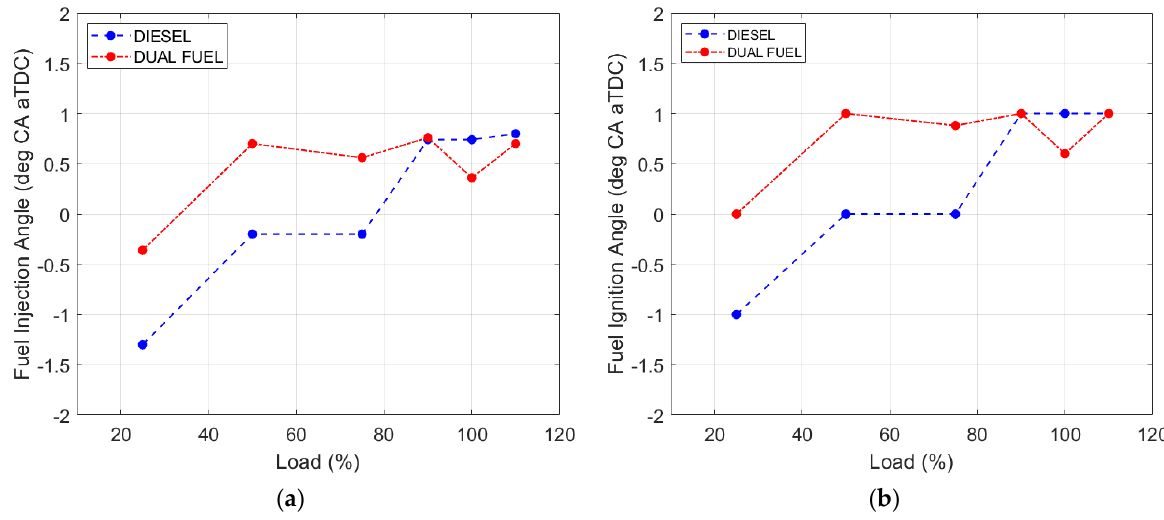
Figure 7. ( a ) Diesel injection angle, diesel and DF modes; ( b ) Diesel ignition angle, diesel and DF modes.